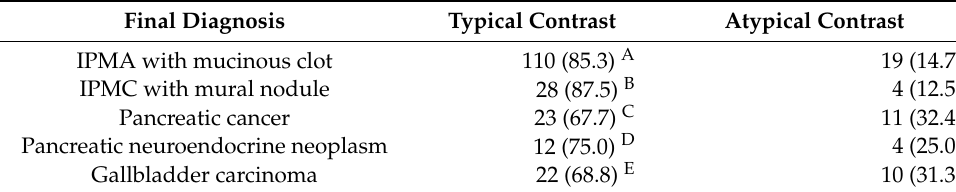
Table 3. Breakdown of typical and atypical contrast-enhanced harmonic endoscopic ultrasonography imaging in the main diseases where the contrast pattern is considered highly characteristic.